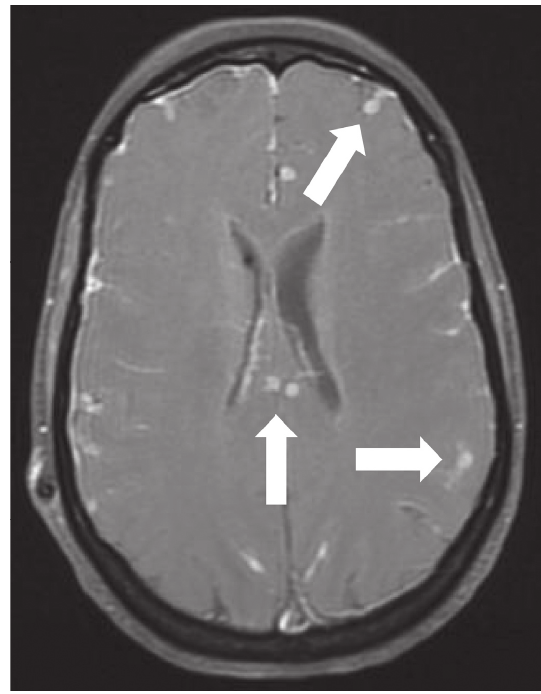
Figure 2: Brain MRI: T1, after gadolinium administration; arrows: multiple